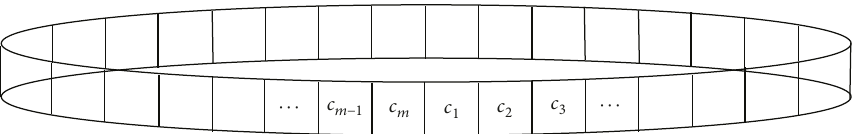
Figure 3: Ring formation of the linear array of cells, where m is the number of